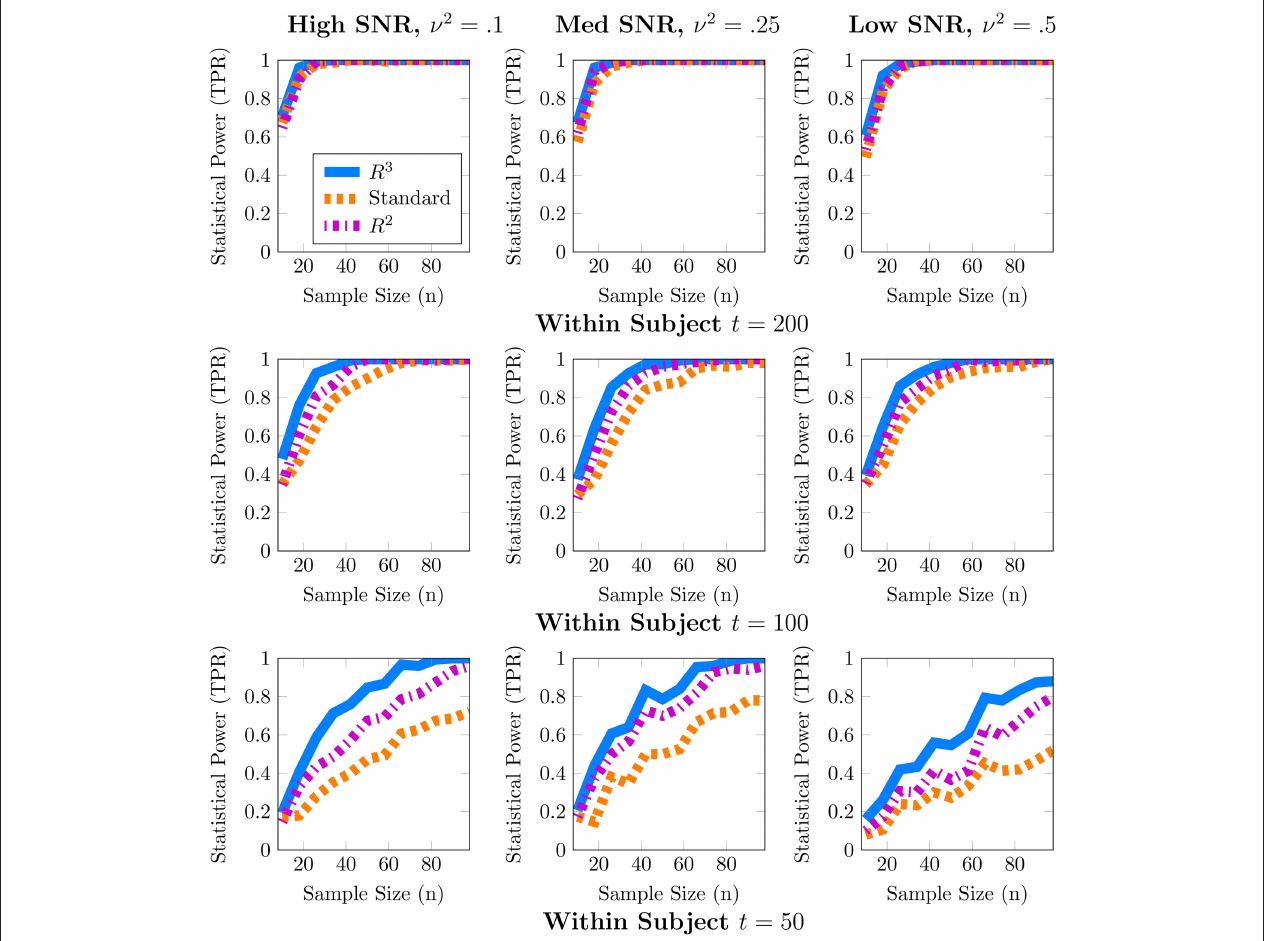
FIGURE 2 | Statistical power analysis for node density. When node density varies with an explanatory covariate ( q = 1 ), statistical power to detect this covariate effect improves with subject sample size n but crucially depends on the number of independent fMRI samples t from a single session and relative size of the covariate effect, β 1 = 1 , to population variance ν 2 (covariate SNR). When t ≈ p , estimates of node density are both highly variable and potentially biased. By accounting for these issues, R 3 and R 2 improve estimates of network metrics, thus exceeding 80% power, whereas the standard F -test is substantially less powerful. Note that R 3 and R 2 are more powerful at smaller sample sizes compared to the standard approach. However, when fMRI samples become sufficiently large at t ≈ 4 p , all methods become similarly powerful for detecting covariate effects of node density. Empirical statistical power is defined as # of times reject Equation (3)